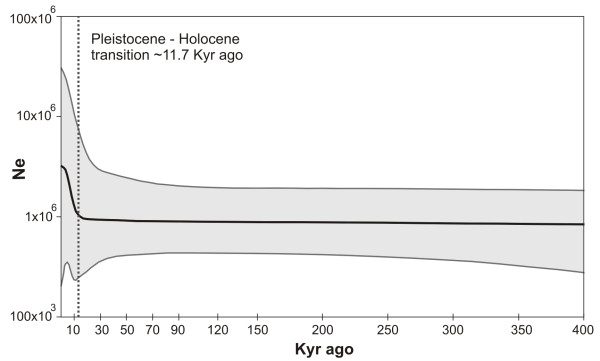
Bayesian skyline plot. Bayesian Skyline Plot for Calibrachoa heterophylla cpDNA showing the effective fluctuation in population size over time, the thick solid line represents the median estimates and the shaded area the 95% confidence interval. The dashed line indicates the Pleistocene-Holocene transition.